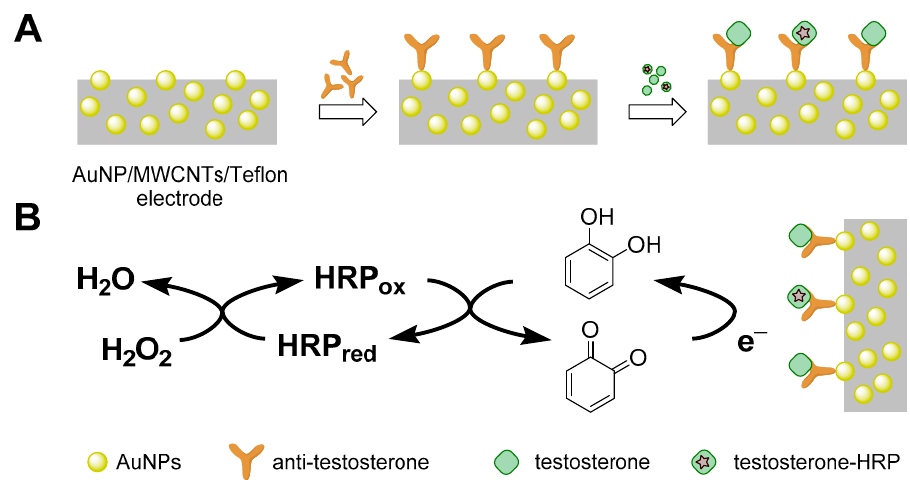
Figure 4. A diagram depicting the principle of an electrochemical testosterone immunosensor using AuNPs (gold nanoparticles)/multi-walled carbon nanotubes (MWCNTs)/Teflon electrodes. Anti- testosterone antibodies were directly attached to the hybrid electrode surface through the interaction of antibody thiol groups with AuNPs ( A ). A competitive assay between testosterone and testosterone conjugated to horseradish peroxidase (HRP–testosterone) was used for binding sites of antibodies. Amperometry at − 0.05 V vs. Ag/AgCl was used to monitor affinity reactions upon the addition of H 2 O 2 with catechol as a redox mediator ( B ) [104].